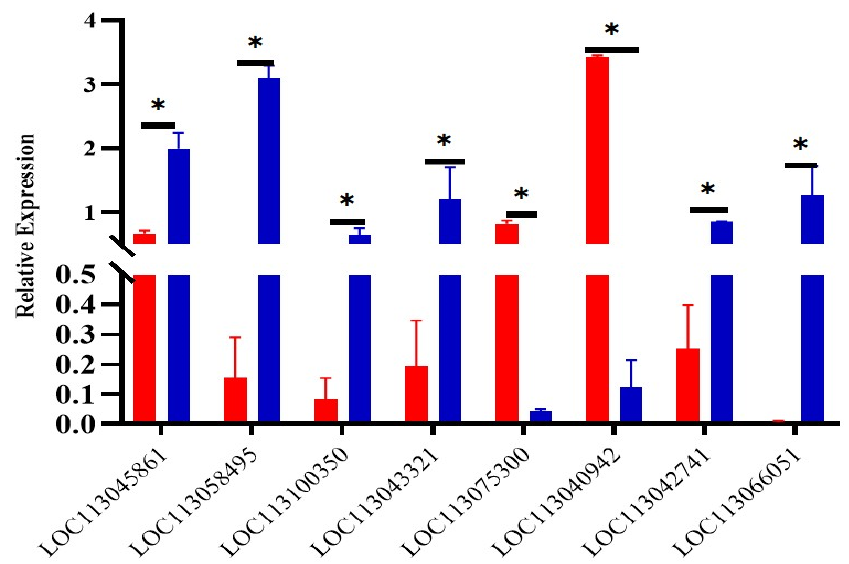
Figure 4. The expression levels of mRNA verified by qPCR. LOC113045861 - LOC113043321 : left: yel- low group, right: brown group; LOC113075300 : left: white group, right: brown group; LOC113040942 - LOC113066051 : left: yellow group, right: white group. * indicates p < 0.05.